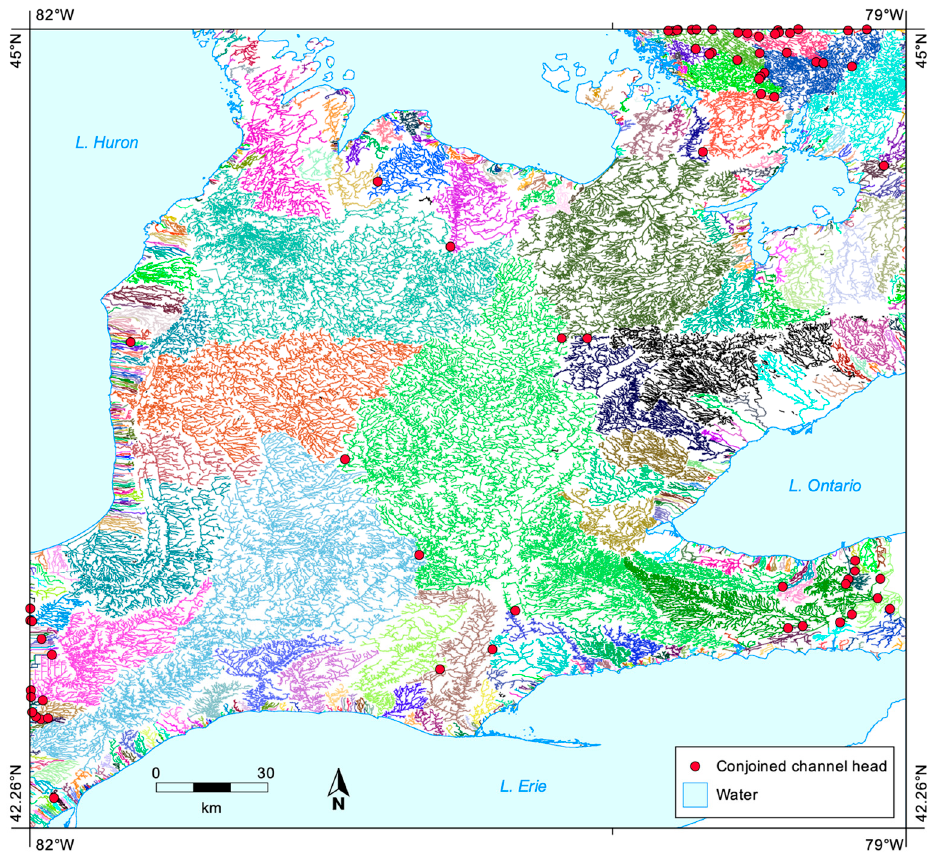
Figure 6. Basins and conjoined channel heads within the Southern Ontario study area. Each unique outlet identifying value is rendered in a randomly assigned color.